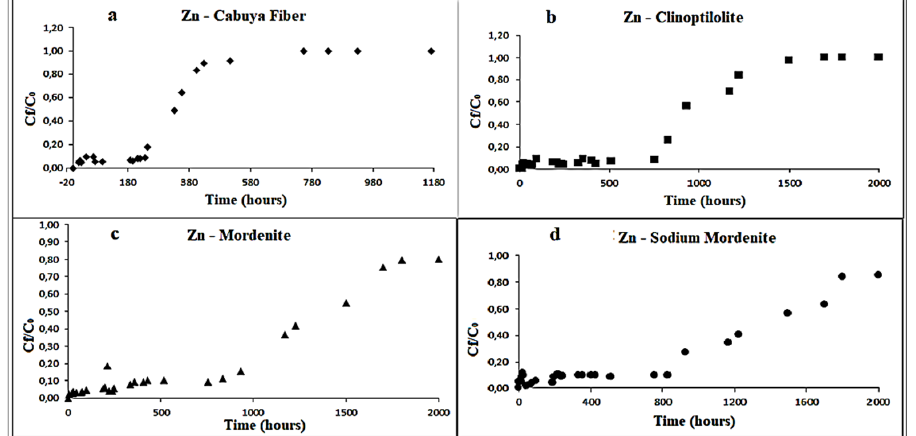
Figure 3. Variation of Zn concentration over time, in the column tests, for the following reactive materials: ( a ) cabuya fiber; ( b ) clinoptilolite zeolite; ( c ) mordenite zeolite; ( d ) sodium mordenite